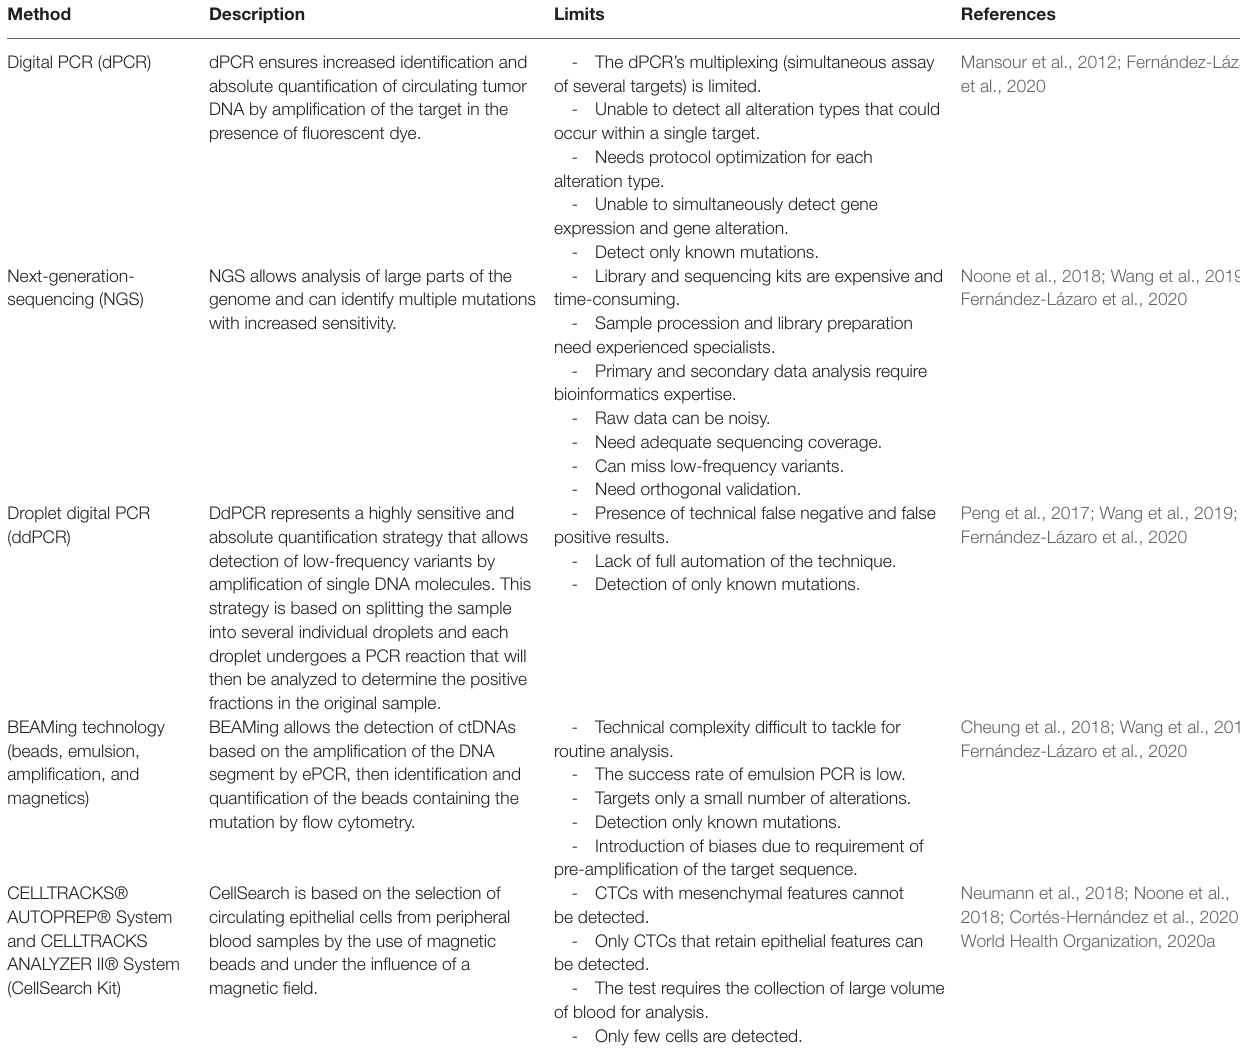
TABLE 1 | The limitations of techniques routinely used for the detection of ctDNA or